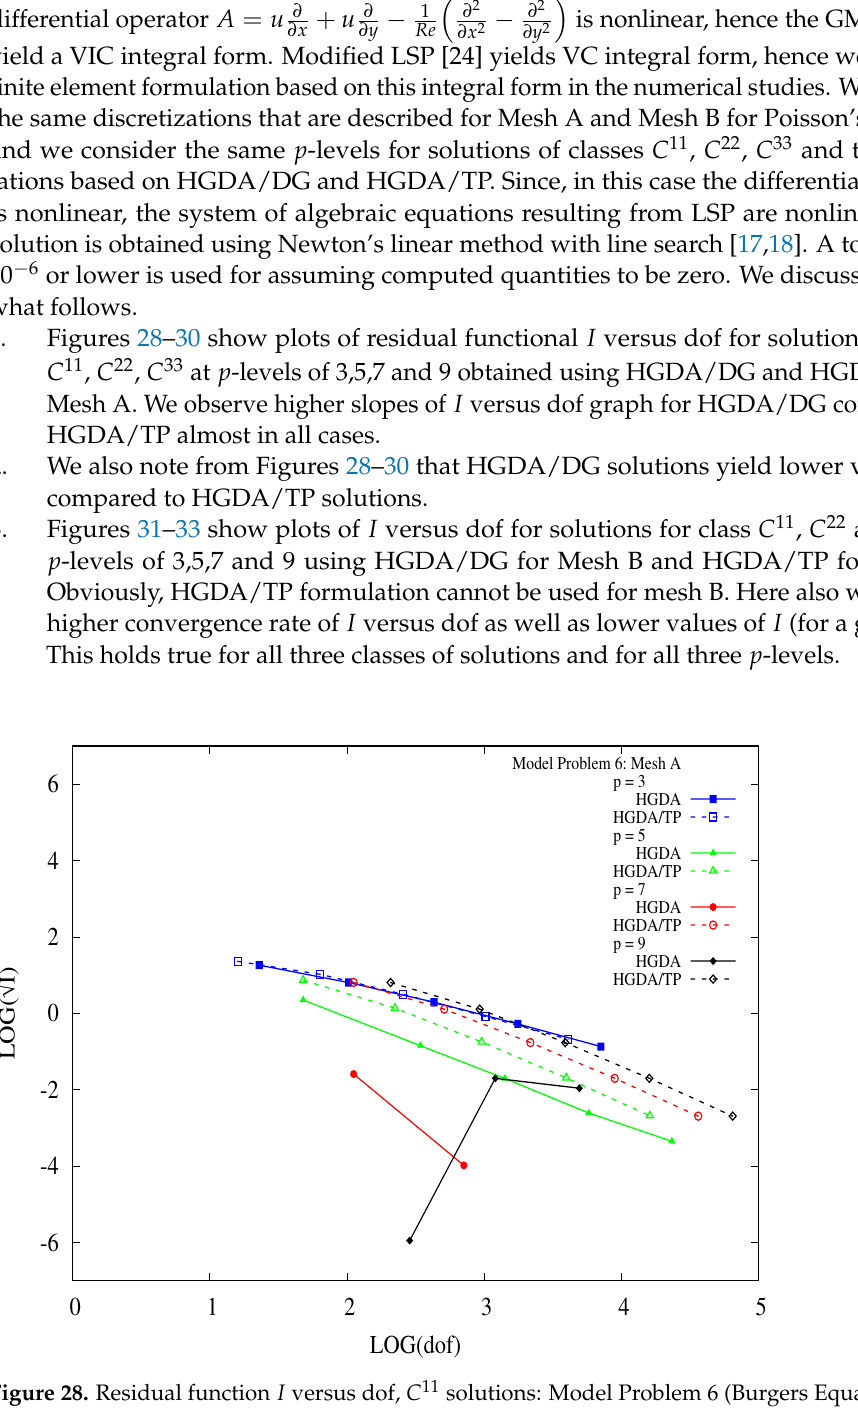
Figure 28. Residual function I versus dof, C 11 solutions: Model Problem 6 (Burgers Equation; Mesh A; HGDA/DG and